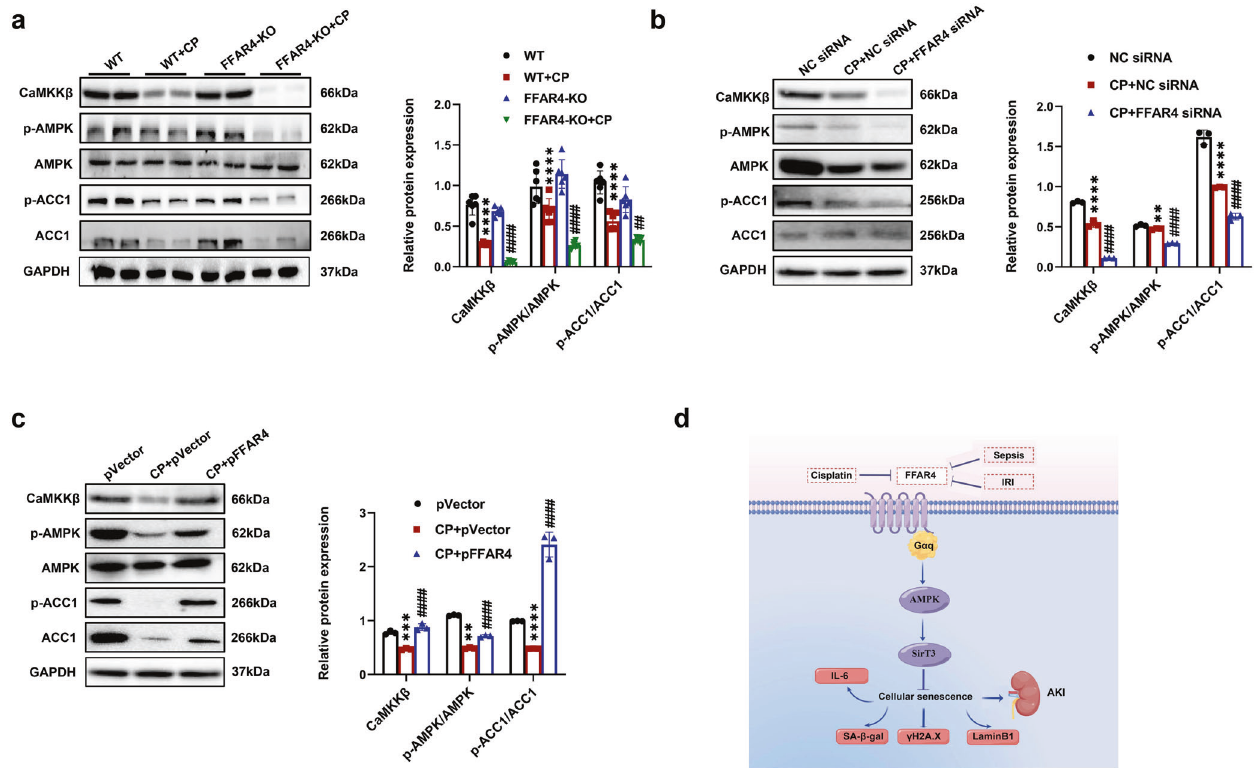
Fig. 10 FFAR4 activates the Gq/CaMKK β /AMPK signaling pathway in cisplatin-induced AKI and TCMK-1 cells. a Protein expression of CaMKK β , p-AMPK/AMPK, and p-ACC1/ACC1 in kidneys detected by western blotting and quanti fi ed by densitometry ( n = 6; **** P < 0.0001, WT + CP vs . WT; #### P < 0.0001 , ## P < 0.01, FFAR4-KO + CP vs. WT + CP). b Protein expression of CaMKK β , p-AMPK/AMPK, and p-ACC1/ACC1 in TCMK-1 cells transfected with FFAR4 siRNA detected by western blotting and quanti fi ed by densitometry ( n = 3; **** P < 0.0001, ** P < 0.001, CP + NC siRNA vs. NC siRNA; #### P < 0.0001, CP + FFAR4siRNA vs. CP + NC siRNA). c Protein expression of CaMKK β , p-AMPK/AMPK, and p-ACC1/ACC1 in TCMK- 1 cells transfected with pVector or pFFAR4 detected by western blotting and quanti fi ed by densitometry ( n = 3; **** P < 0.0001, *** P < 0.001, ** P < 0.01, CP + pVector vs. pVector; #### P < 0.0001, CP + pFFAR4 vs. CP + pVector). d Schematic illustration of FFAR4 in cellular senescence of AKI. Data are presented as mean ± SD. CP